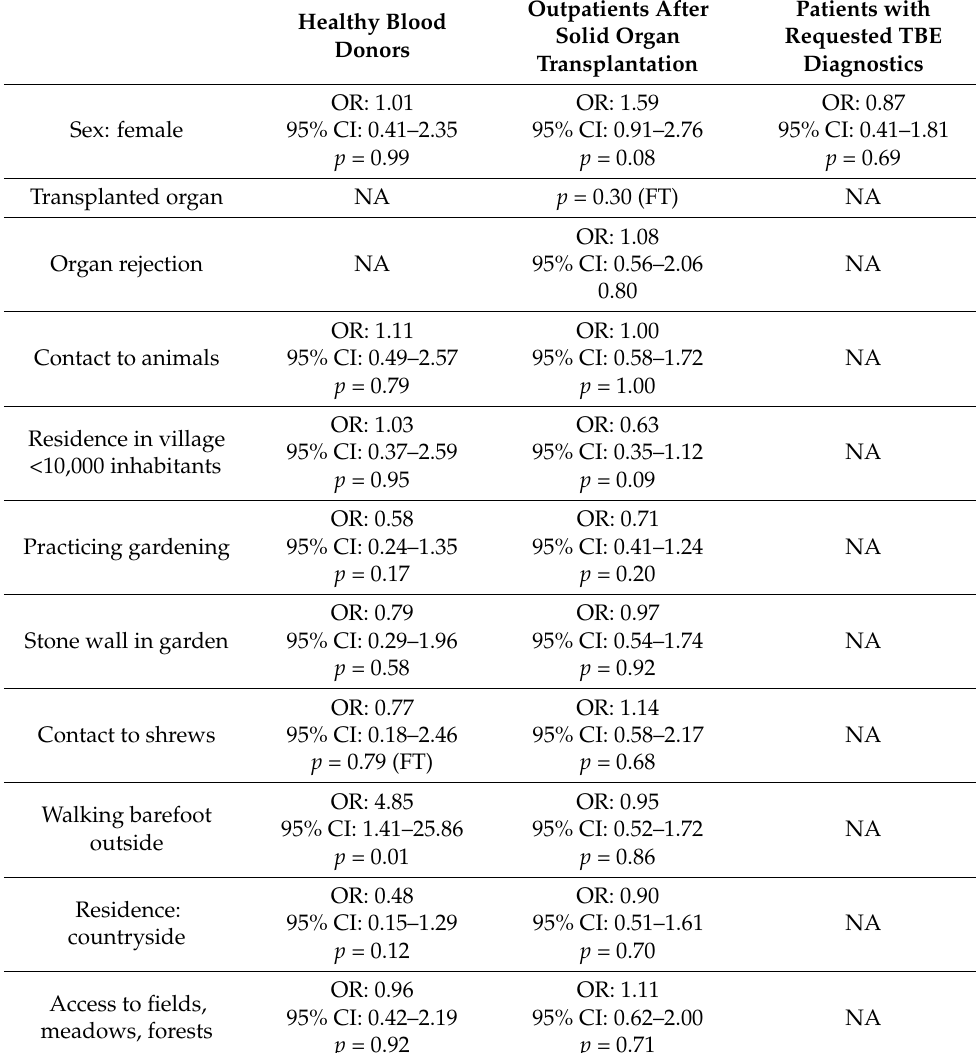
Table 2. Contingency analysis of questionnaire and ELISA screening (reactivity against ≥ 1 antigen).